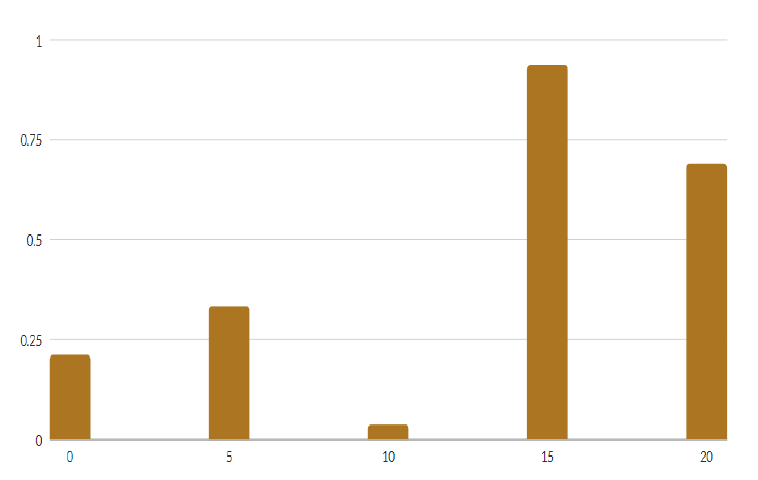
Figure 3. Closeness coefficient graph using